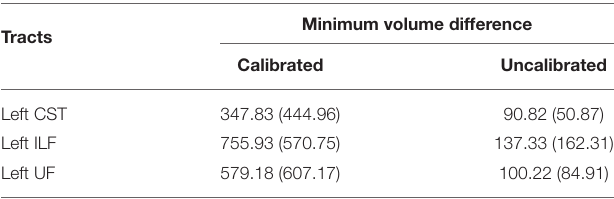
TABLE 5 | The minimum volume difference between ground truth volume and the predicted volume for the Hybrid method before and after calibration.